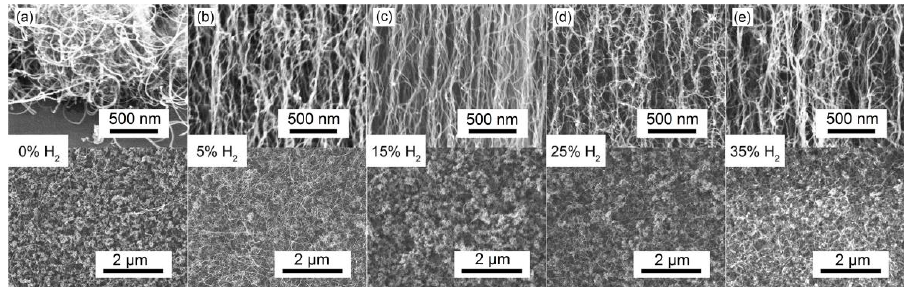
Figure 1. SEM images showing side (above) and top (below) views of Vertically-aligned carbon nanotubes (VACNTs) created under different H 2 concentrations: ( a ) 0%; ( b ) 5%; ( c ) 15%; ( d ) 25%; ( e ) 35%.